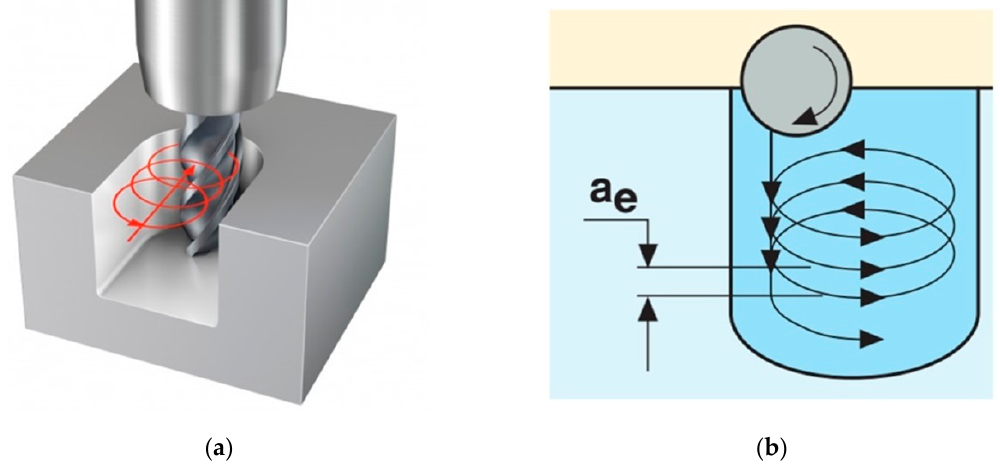
Figure 1. Schematic diagram of the groove processing in the trochoidal milling strategy: ( a ) the isometric view of the end mill trajectory (Sandvik); ( b ) the end mill trajectory in the plane with the radial depth of cut (a e ).